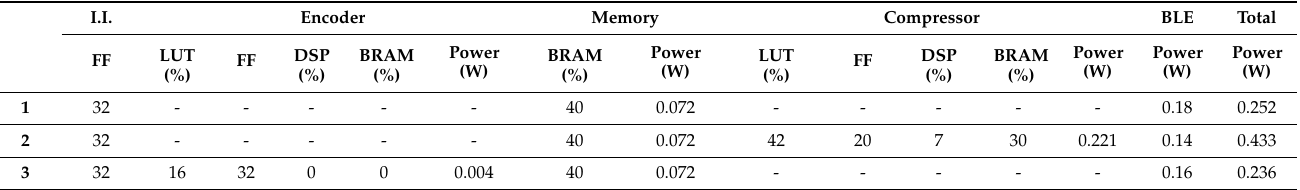
Table 2. Comparison of three configurations in Xilinx ZYNQ-7000